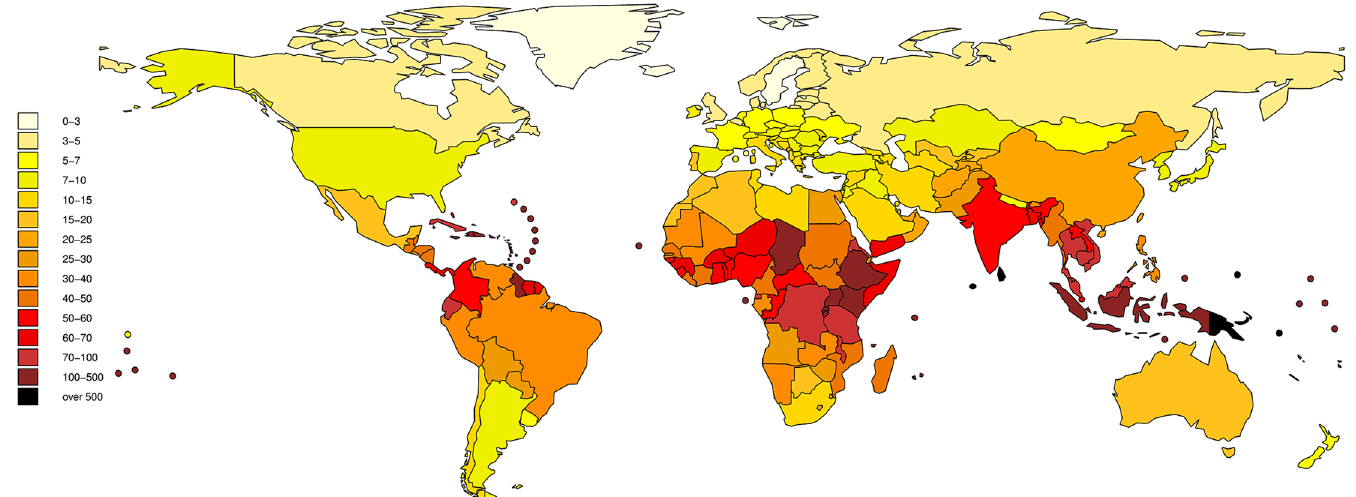
Fig 4. Burden of leptospirosis in terms of DALYs/100,000 per year.